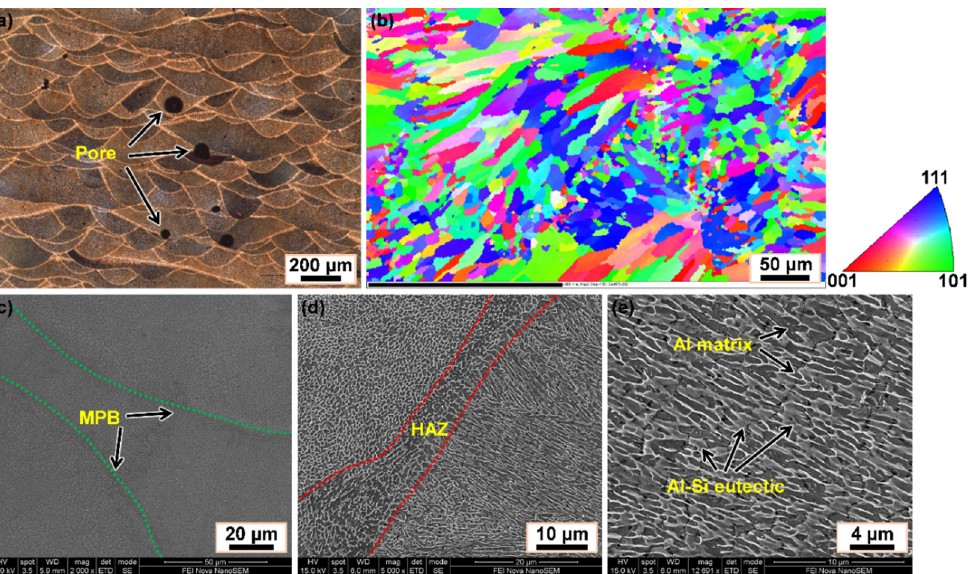
Figure 1. Microstructures of the SLMed AlSi10Mg alloy: ( a ) optical micrograph; ( b ) EBSD IPF map; ( c – e ) SEM micrographs in different magnification. (Note: the dotted lines in ( c ) represent the melt pool boundary (MPB), while the heat-affected zone (HAZ) in ( d ) is drawn between the two dashed lines).